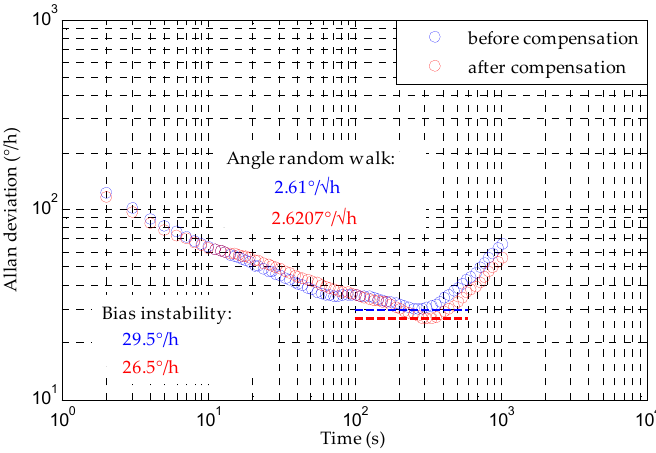
Figure 16. Allan deviation before and after bias compensation.